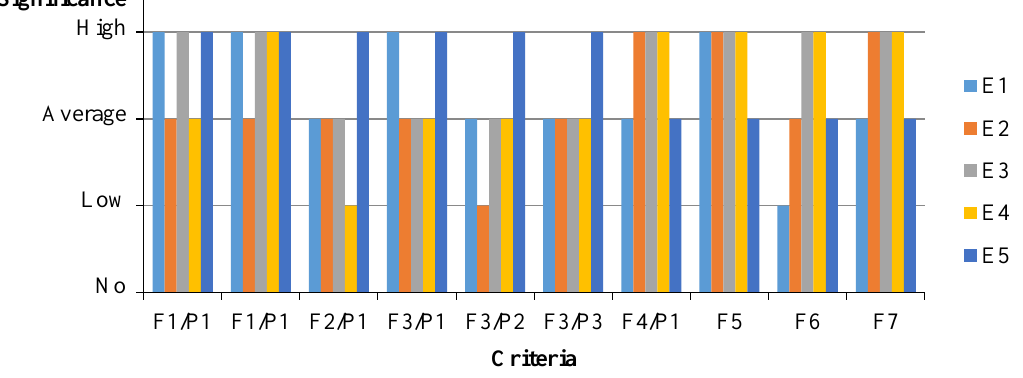
Figure 13. Significance of individual criteria according to expert assessment (E1, E2, ... ,E5 – experts). As a result of processing the input data, the influences and susceptibilities of individual alternatives have been determined in both positive and negative relationships. Their fuzzy form is shown in Figures 14–17.